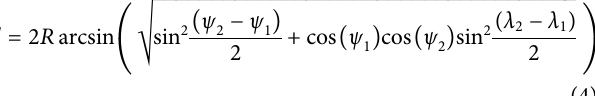
Frontiers in Earth Science |